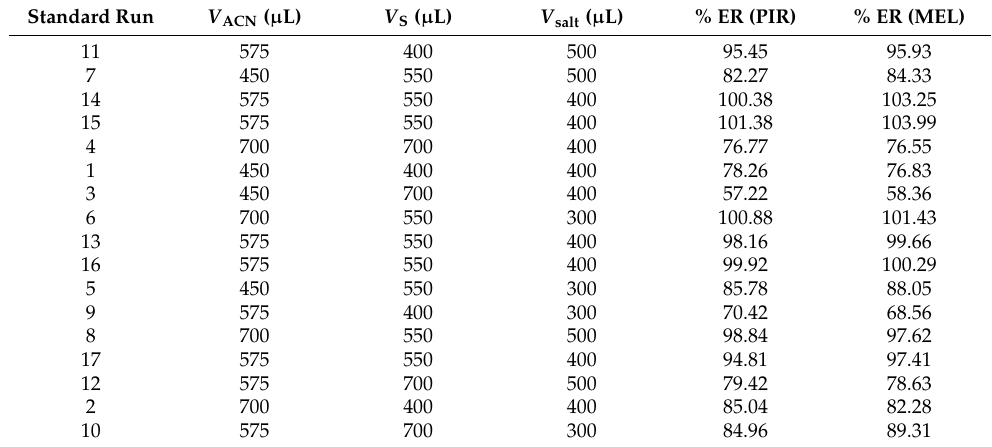
Table 2. Experimental runs generated by BBD for the optimization of SI-HLLME